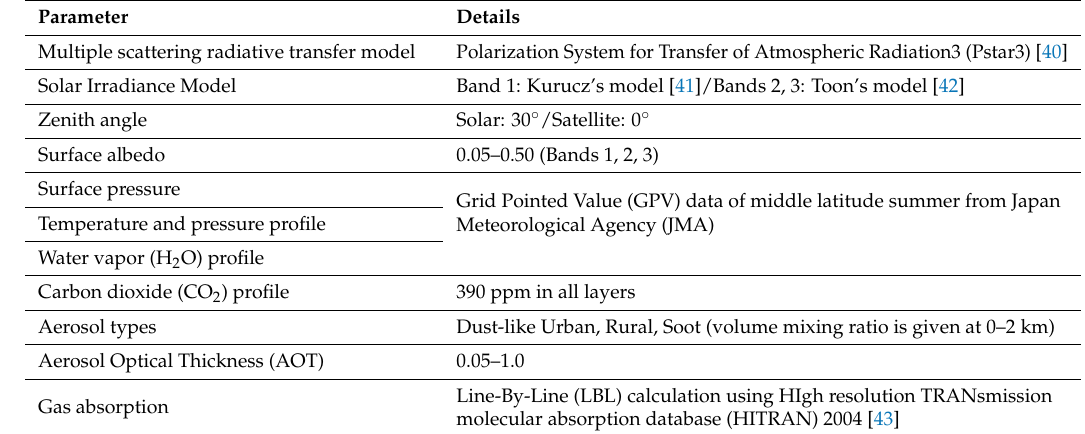
Table 1. Parameter settings and datasets for simulating spectral